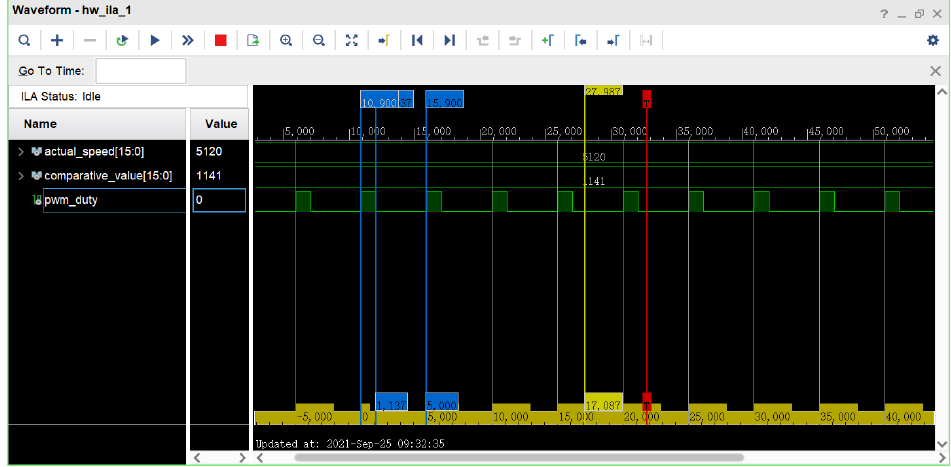
Figure 24. Embedded logic analyzer (ILA) acquisition signal